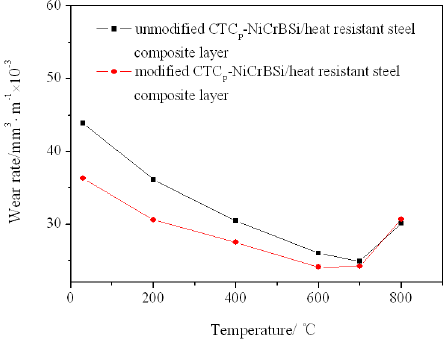
Figure 15. Wear rates of the CTC P -NiCrBSi/heat resistant steel composite layers as a function of testing temperature.